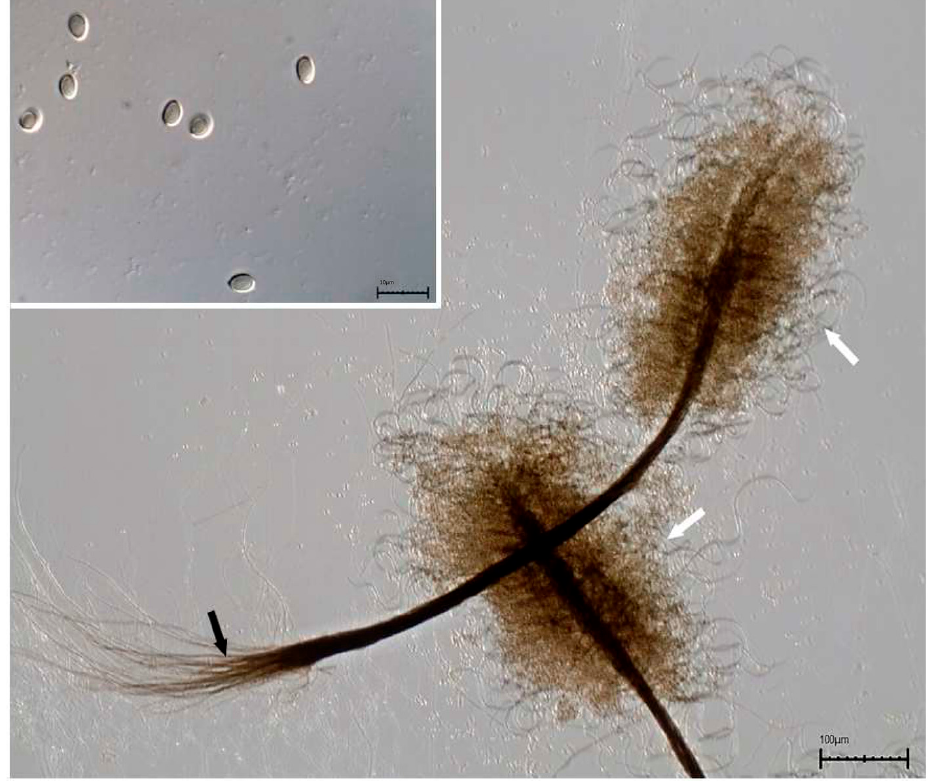
Figure 3. Typical morphology of Cephalotrichum gorgonifer . The main image shows two synnemata with long rhizoids (black arrow) and a head ornamented with curled setae (white arrow). The small image shows the conidia, which are one-celled, pale brown, smooth-/thick-walled, and ellipsoidal conidia pointed at the apex and truncated at the base.